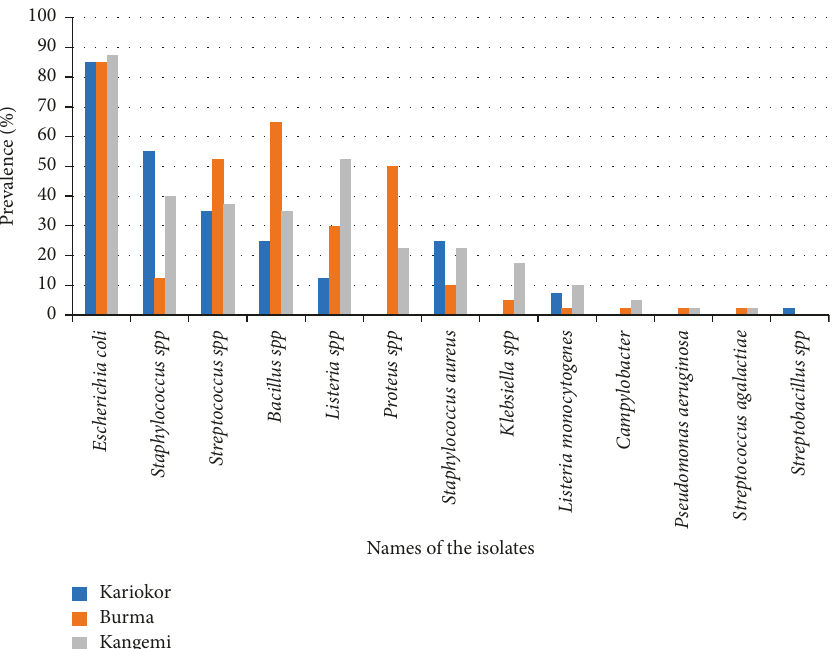
Figure 3: Prevalence rates of isolates per